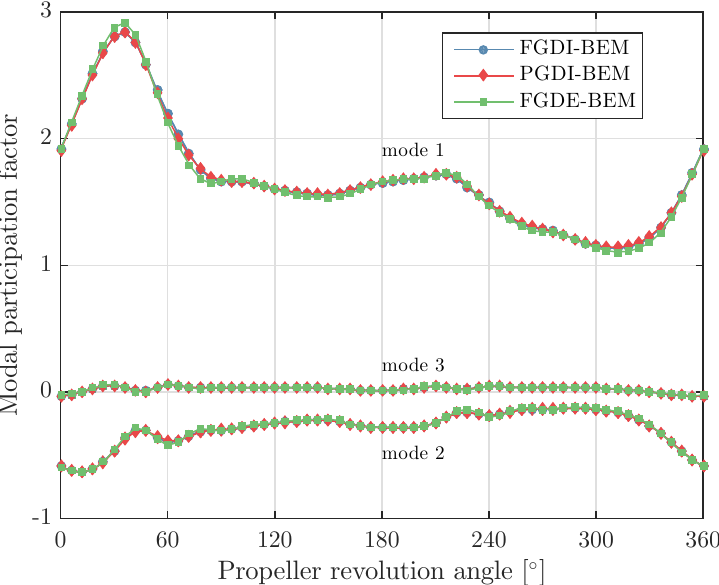
Figure 15. Modal participation factors for the first three modes computed with different BEM-FEM couplings for the carbon–epoxy Seiun–Maru